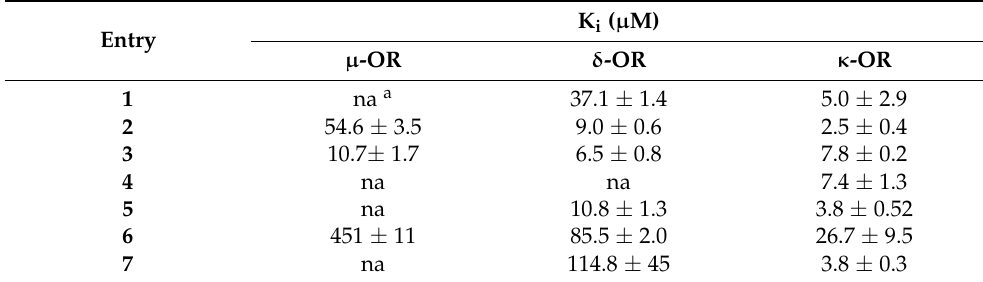
Table 1. Binding affinities of compounds 1 – 7 for ORs ± SEM (n ≥ 3).